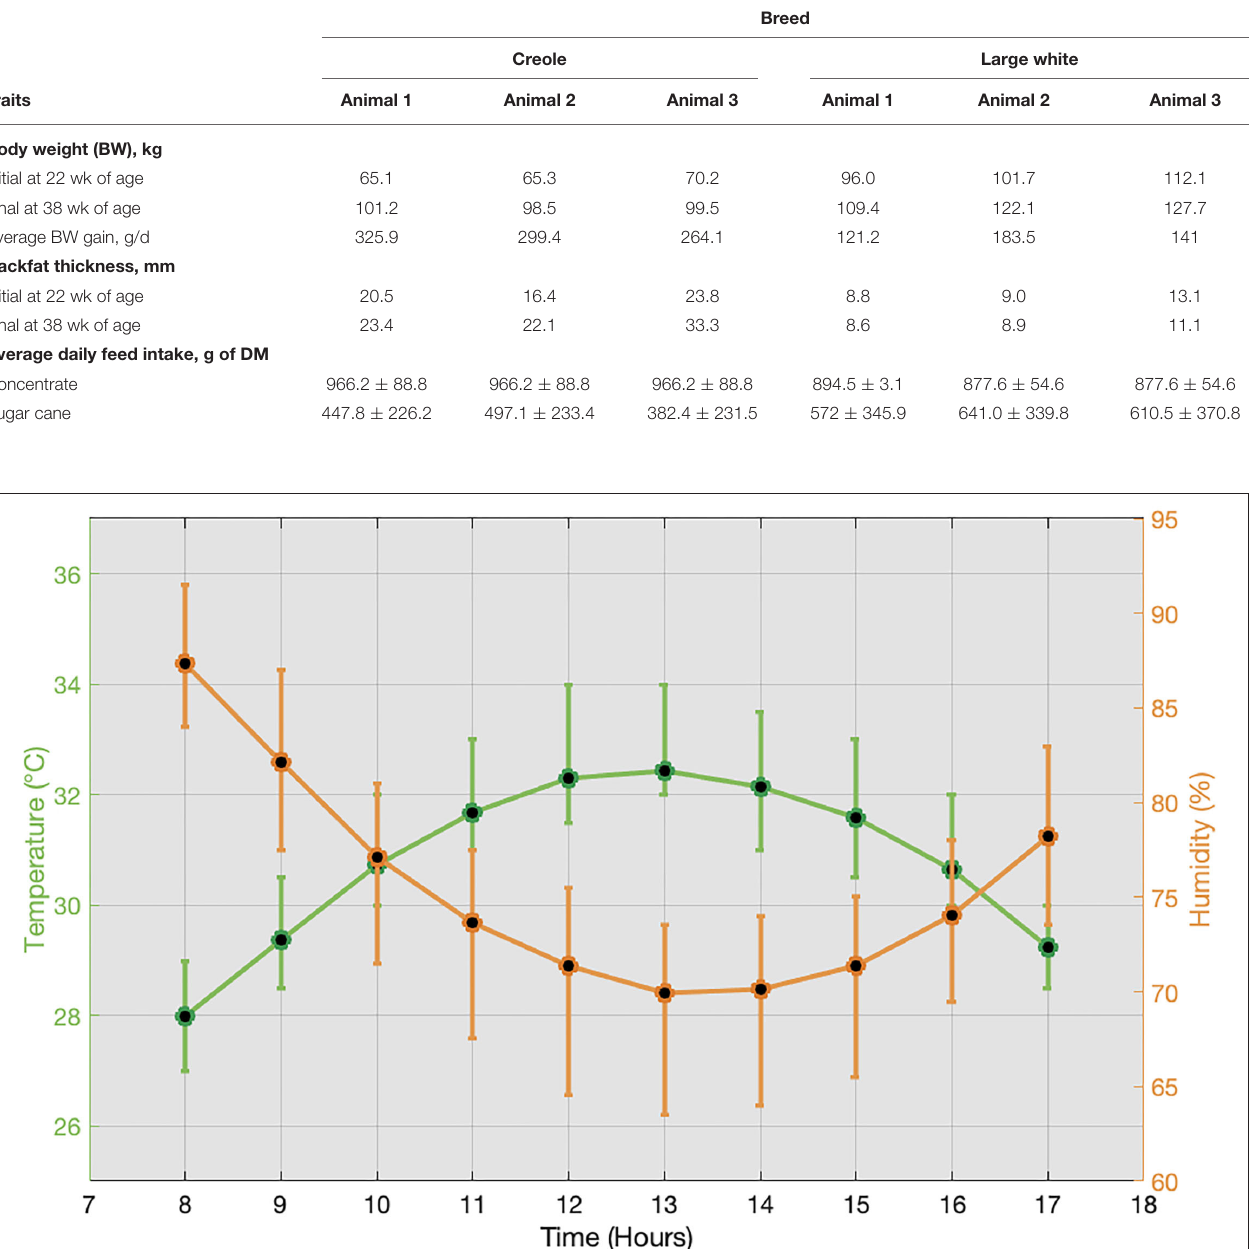
TABLE 2 | Animal growing performances according to breed.